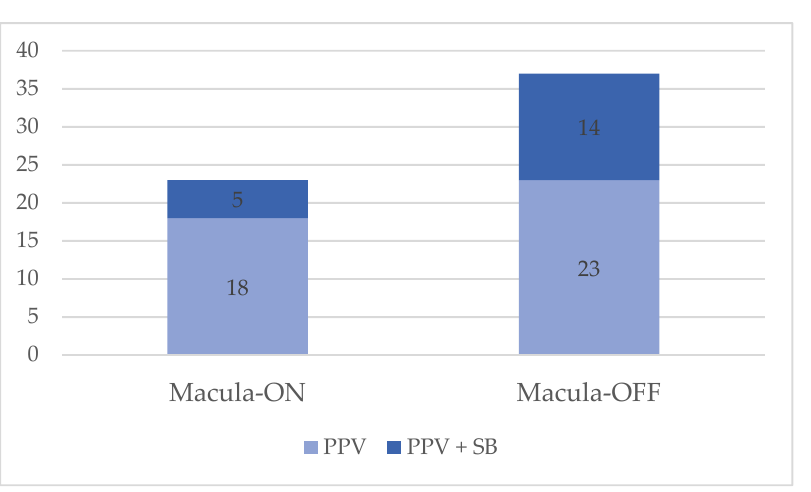
Table 2. Vessel density (VD) in superficial and deep retina capillary plexuses (SCP, DCP) and choriocapillaris plexus (CC) measured with Deep-Range Imaging (DRI)-Triton OCTA in macula-on RRD and macula-off RRD eyes, depending on the surgical procedure, and control eyes.